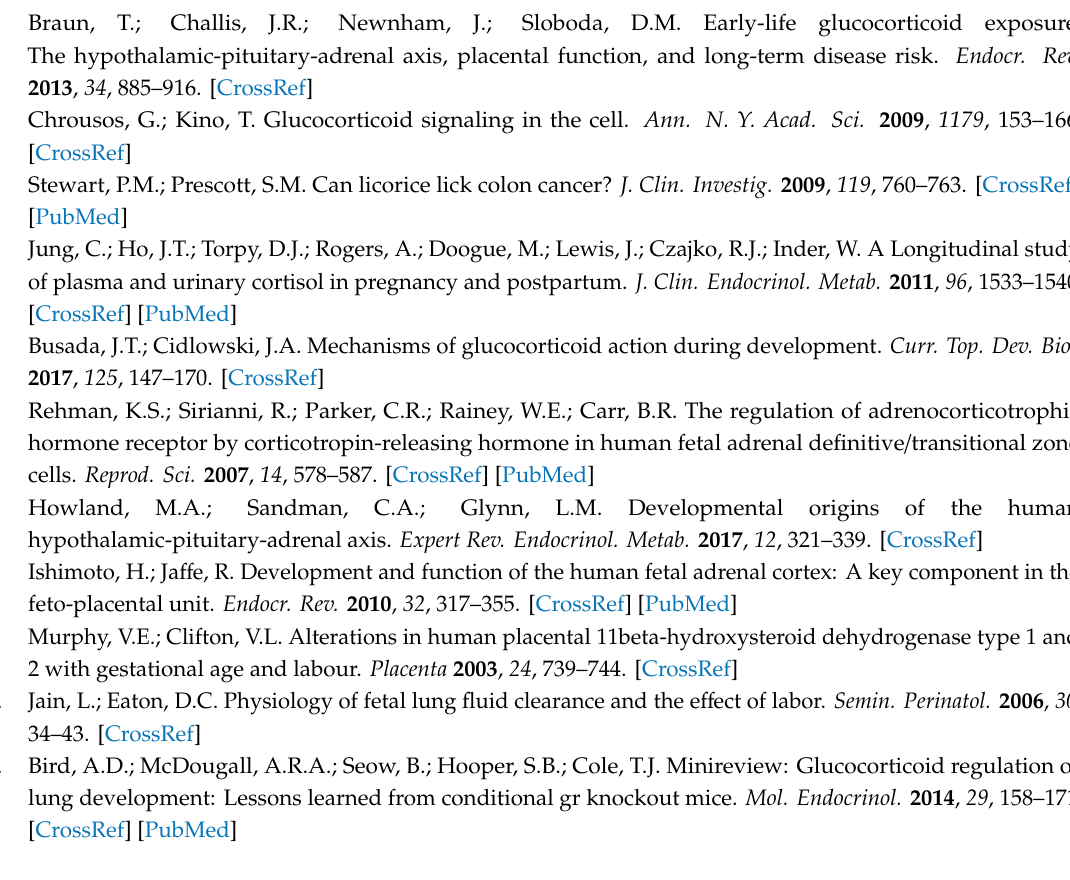
Supplementary Materials: The following are available online at http: // www.mdpi.com / 1660-4601 / 17 / 15 / 5566 / s1, Figure S1: Placental 11 β -HSD 2 in three modes of delivery. Notes: p for Mann-Whitney’s test. The numerical values next to the boxes represent median. Figure S2: Umbilical cord blood cortisol in three modes of delivery. Notes: p for Mann-Whitney’s test. The numerical values next to the boxes represent median. Figure S3: Correlation between placental 11 β -HSD 2 and umbilical cord blood cortisol in three modes of delivery. Notes: r—Spearman’s correlation coe ffi cient. Figure S4: Placental 11 β -HSD2 and umbilical cord blood cortisol versus newborn gender. Notes: p for Mann-Whitney’s test. The numerical values next to the boxes represent